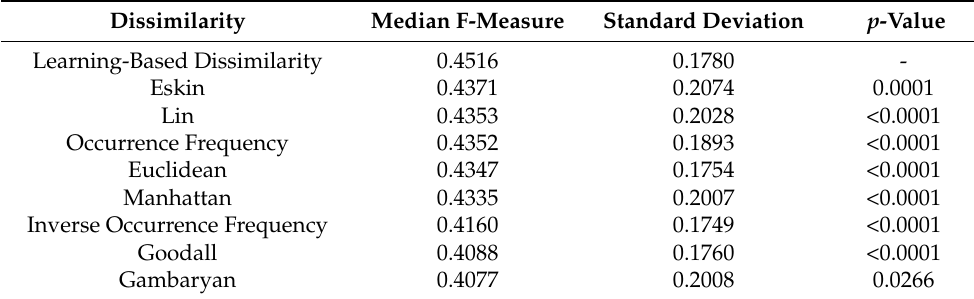
Table 5. Statistical results, according to F-measure [16], for KMeans++ using all the dissimilarity measures, considering all the tested datasets. The last column corresponds to the p -value obtained when comparing Learning-Based Dissimilarity against the other dissimilarity measures using the Wilcoxon signed-rank test [22]. The results are sorted from top to bottom in descending order of the associated F-measure group